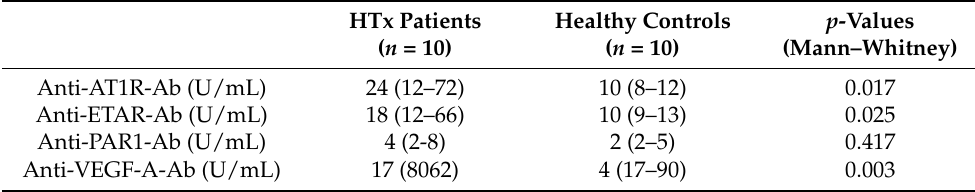
Table 4. Assessment of non-HLA antibodies.